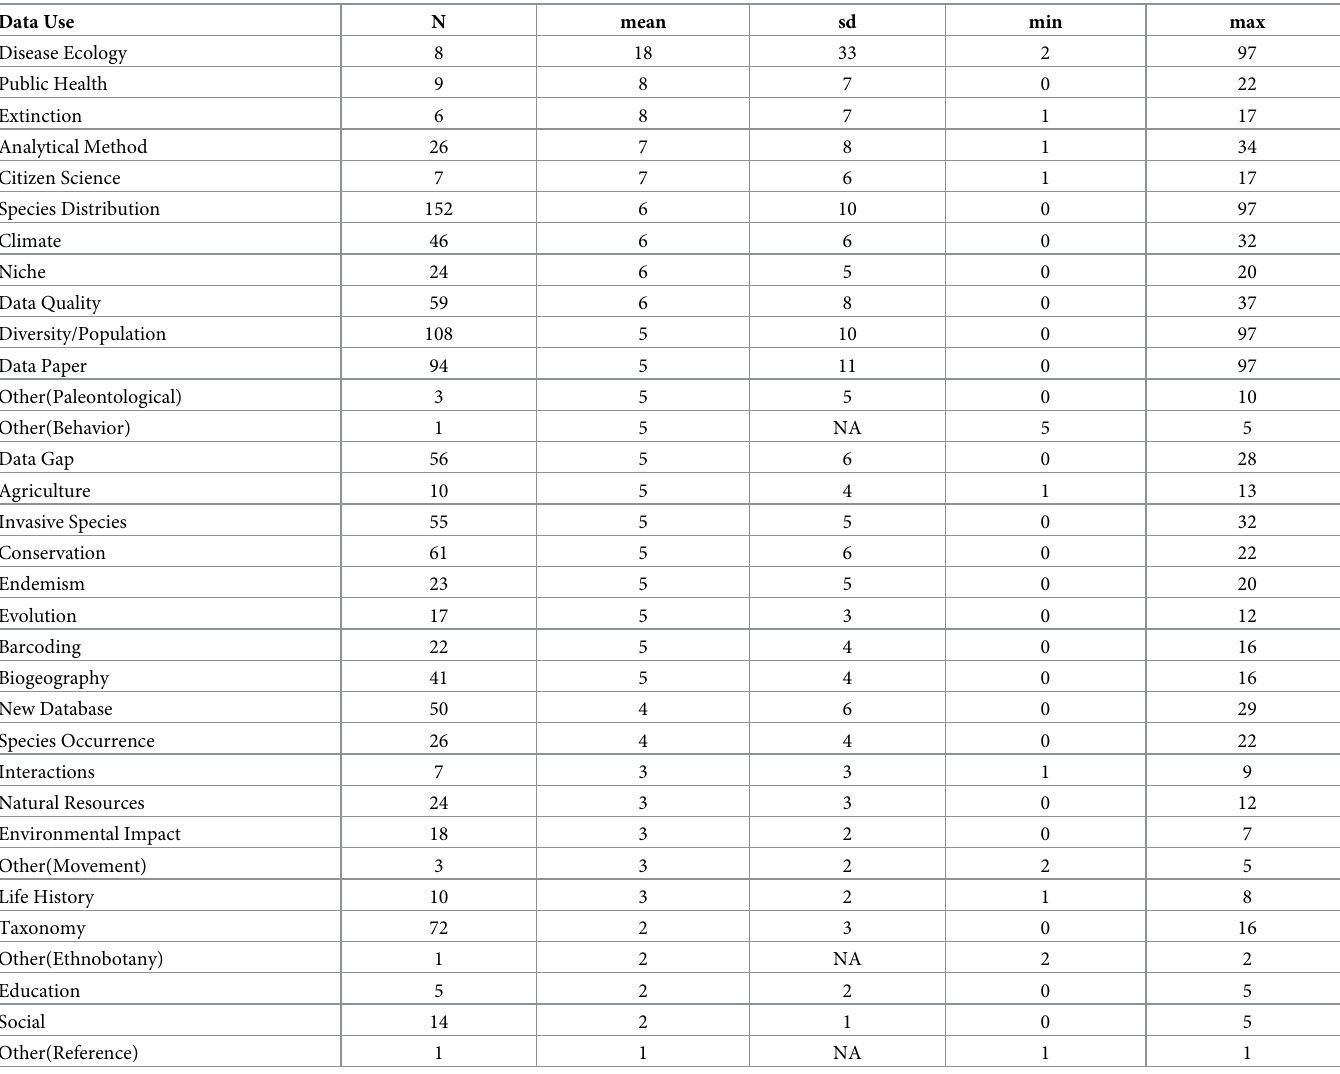
Table 2. Summary statistics for the number of citations per year for each use of primary biodiversity data. Note that not all papers had citation data available.